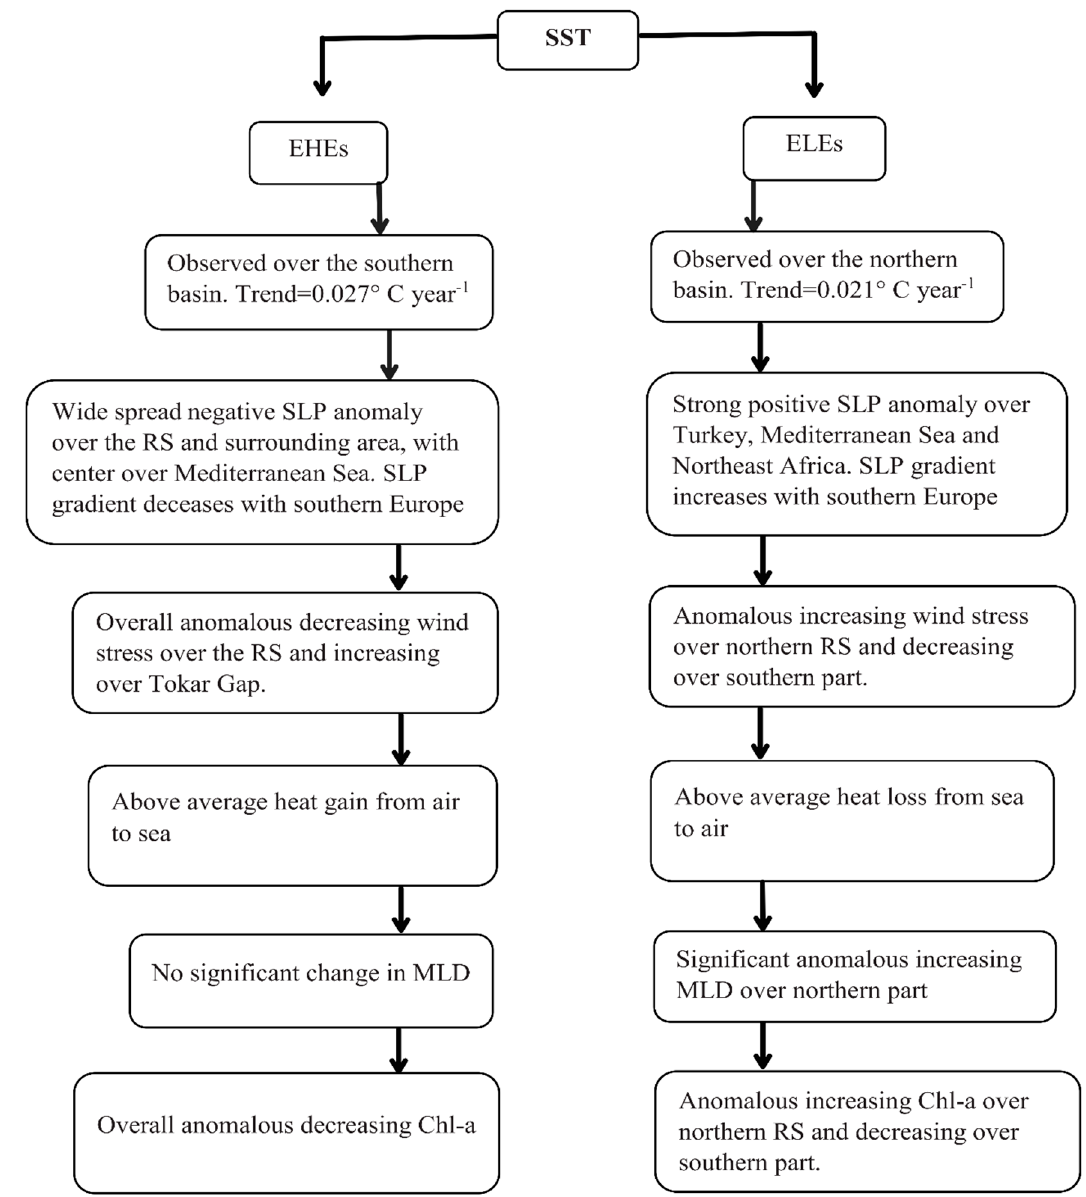
Figure 8. Schematic diagram for the occurrence of EHEs and ELEs due to atmospheric forcing. EHEs during the summer period mainly occur over the southern RS when the westward monsoonal trough is dominant and adjoins the equatorial African low belts, including the Red Sea Trough and Sudan thermal low. Negative SLP anomalies are widespread over the RS and surrounding area, centered over the Mediterranean Sea. The SLP gradient deceases in southern Europe. Overall, anomalous wind stress decreases over the RS and increases over the Tokar Gap area. Overall, anomalous Chl-a values decrease due to the stably stratified ocean boundary layer. This is a straightforward negative consequence of EHEs on the chlorophyll